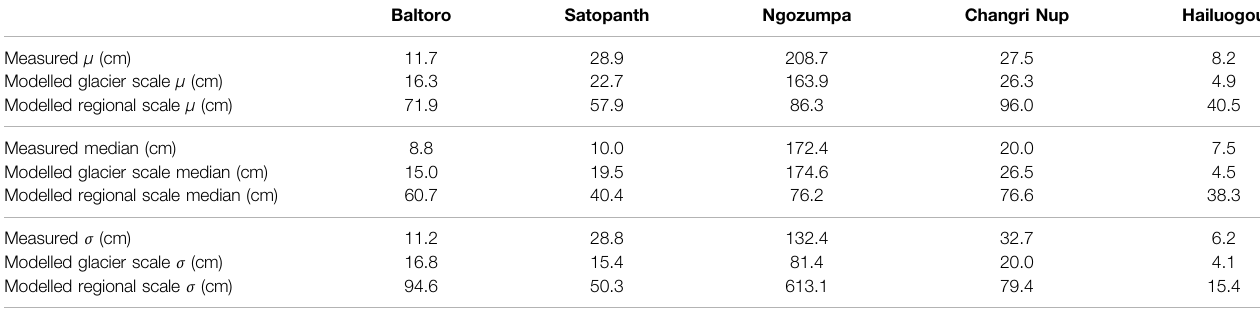
TABLE 4 | Correlations between debris thicknesses derived at a glacier scale and selected glaciological characteristics (aspect, slope, curvature, velocity, and elevation). Baltoro DT